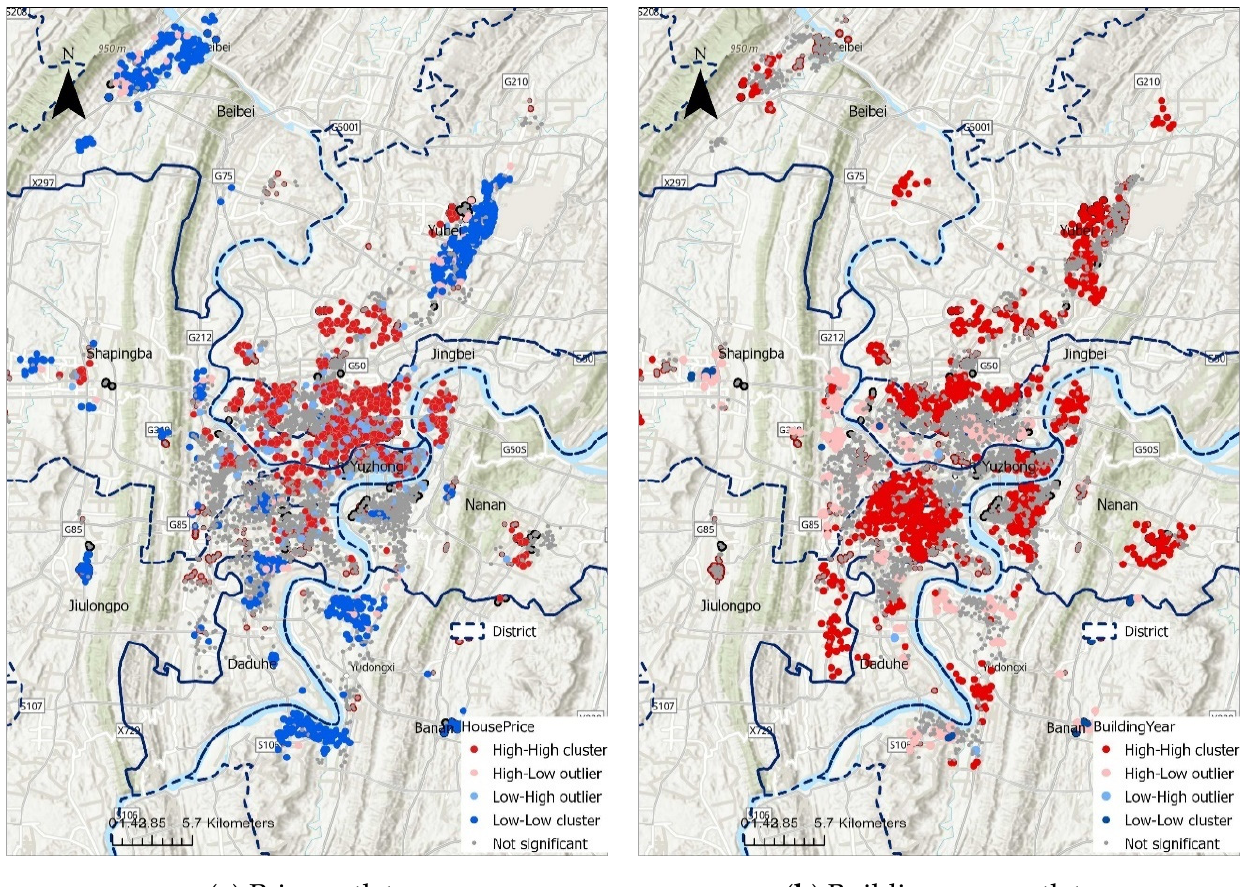
Figure 3. The price and building year of communities in Chongqing.